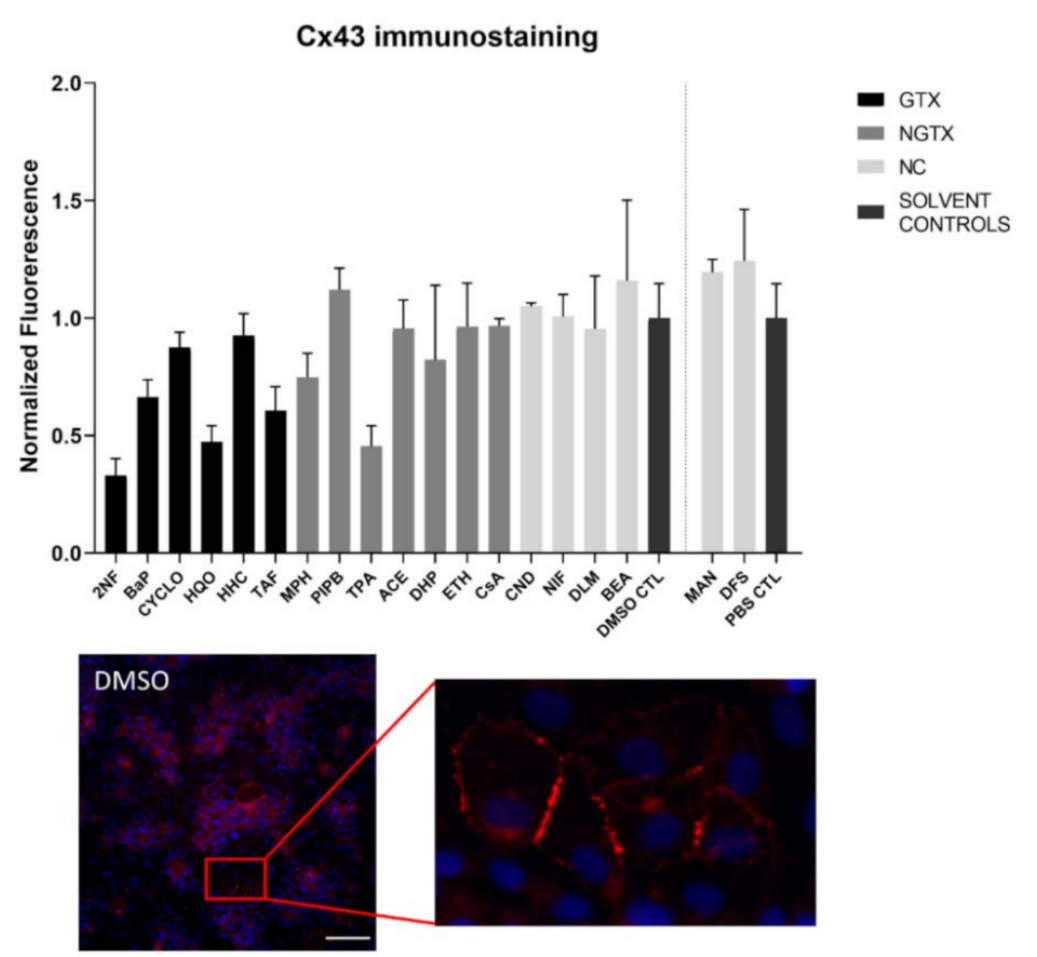
Figure 9. Cx43 protein localization in human hepatoma HepaRG cells exposed to GTX, NGTX and NC chemicals. Human hepatoma HepaRG cells ( n = 1 and N = 1; at least 3 images per well) were exposed to GTX, NGTX, and NC chemicals for 72 h. The area and intensity of the fluorescent signal was quantified via ImageJ software (version 1.52p, Bethesda, MD, USA) and normalized to the fluorescent signal of the respective solvent control (DMSO CTL or PBS CTL). Significant difference compared to the solvent control was calculated with a non-parametric Kruskal-Wallis test followed by a Dunn’s multiple comparison test. Data are expressed as mean ± standard deviation. No significant changes were measured. Scale bar = 100 µ M, 20 ×